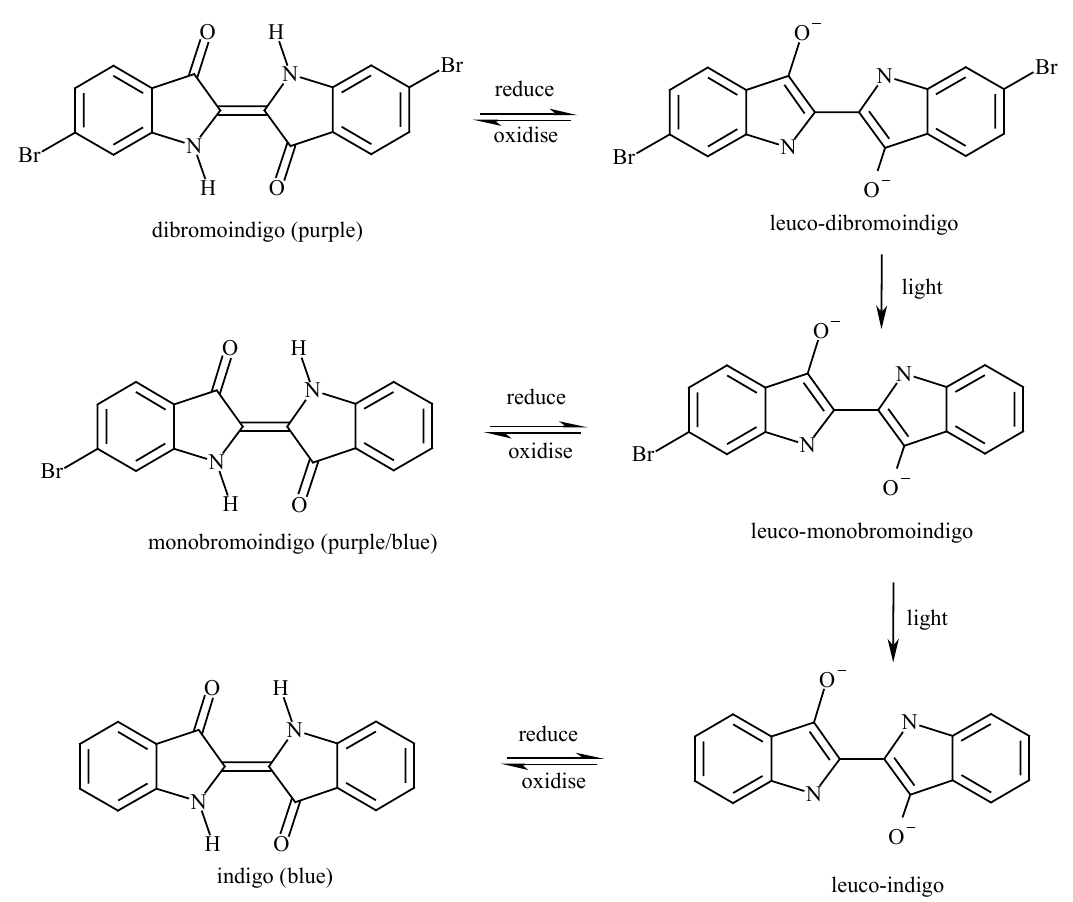
Figure 13. The reduction of indigos to leucoindigos and the photodebromination of